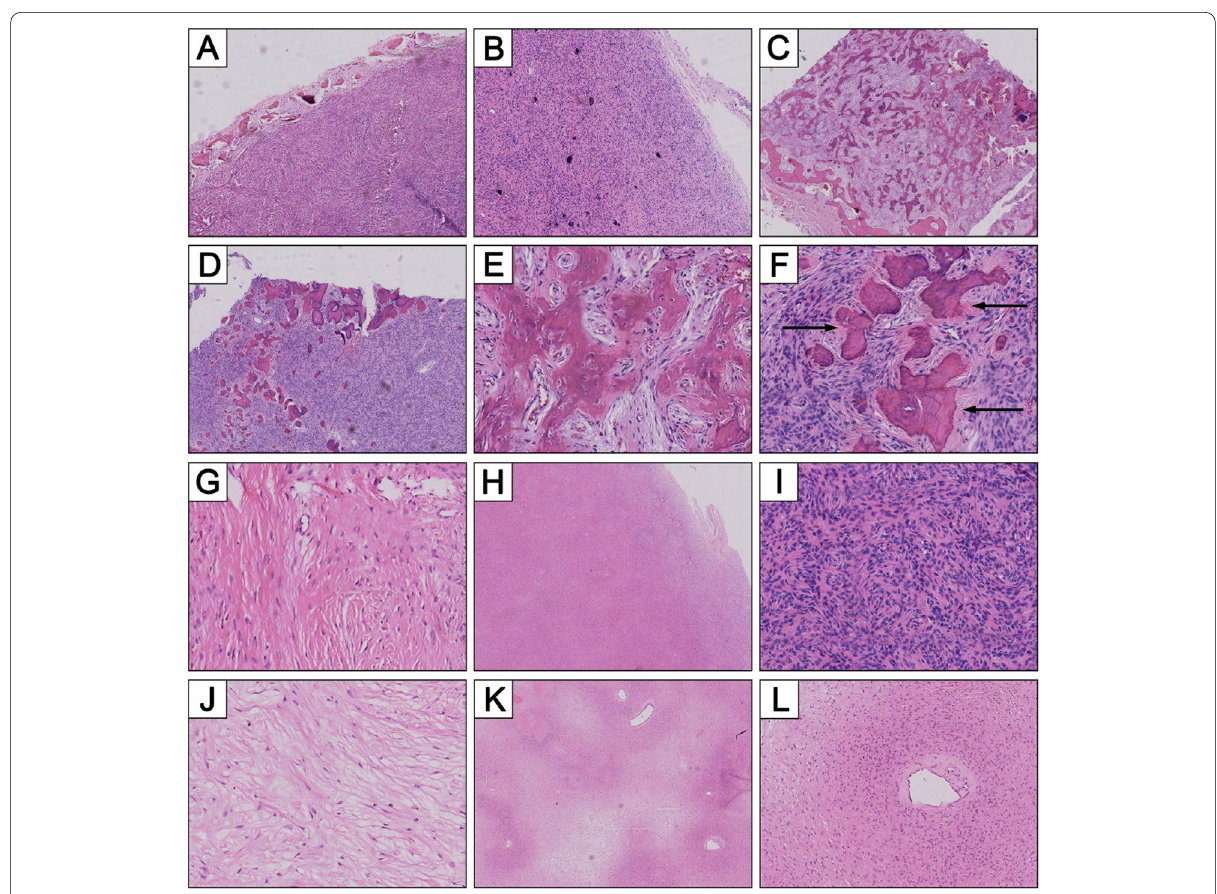
Fig. 2 Representative pathological findings of OF in both patient II:2 and III:1. A The well-demarcated tumor showing hypercellularity component. B A partly encapsulated leision in which psammomatoid calcified spherules lying in hypercellular stroma. C A mineralization component of the lesion and a thin layer of fibrous tissue which separated from the surrounding normal bone. D Low power H&E image demonstrates interface between mineralized and non-mineralized tissue. E Cellular osteoid trabeculae formation lacking of typical osteoblastic rimming, mineralization often at the center of these trabeculae (medium-magnification photomicrograph of C ). F A medium power view of D showing acellular basophilic cementum-like structures. The calcified tissue shows a distinctive “brush boarder” that interfaces with the surrounding stroma (arrows). G Hypocellular area with collagenized stroma cells. H Fibrous component with moderatecellular density, absence of calcifications completely (low-magnification image). I Dense fibrous cells are hyperchromatic and absence of mitosis. J Hypocellular area demonstrating loose edema-like stroma. Low-magnification (K) and high-magnification (L) photomicrographs showing a perivascular growth pattern (perivascular cells are relatively higher density than those of away from